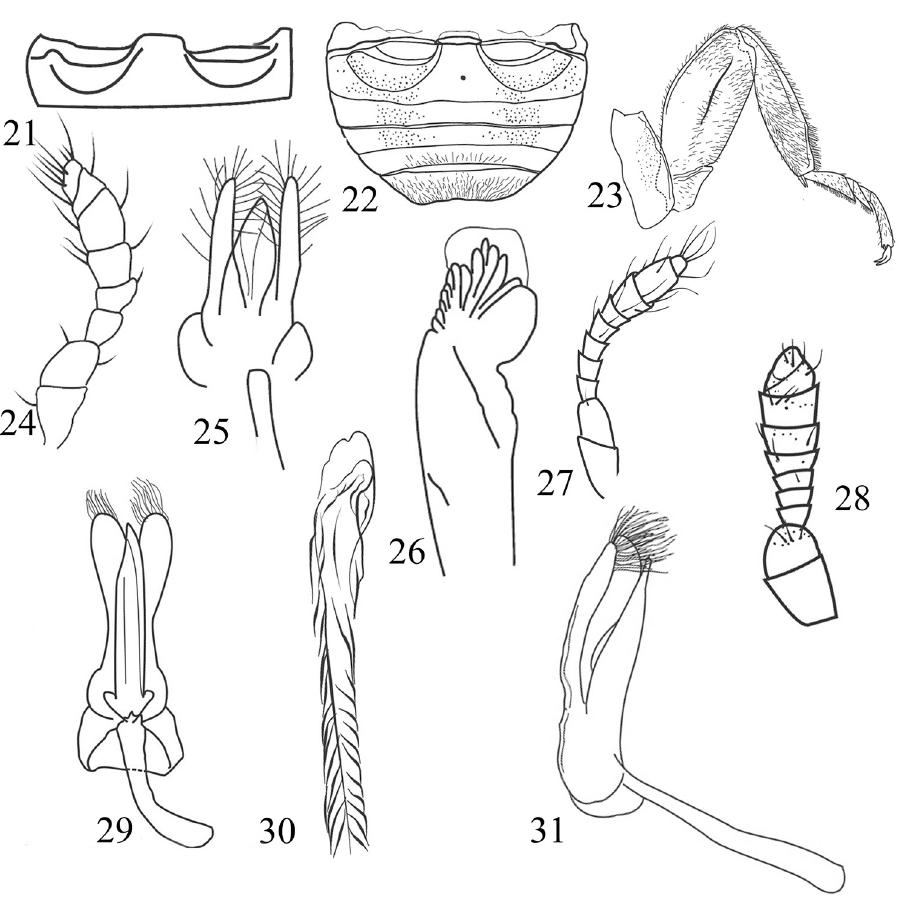
Figures 21–31. Morphological details and male genitalia of Chilocorini species. 21 , 24–26 Brumoides adenensis : 21 Abdominal postcoxal lines 24 Antenna 25 Tegmen 26 Penis apex 22 Parexochomus pube- scens : Abdominal postcoxal lines 23, 28 P. nigripennis : 23 Hind leg 28 Antenna 27 Exochomus undulatus : Antenna 29–31 E. quadriguttatus : 29 Tegmen, ventral view 31 Tegmen, lateral view 30 Penis